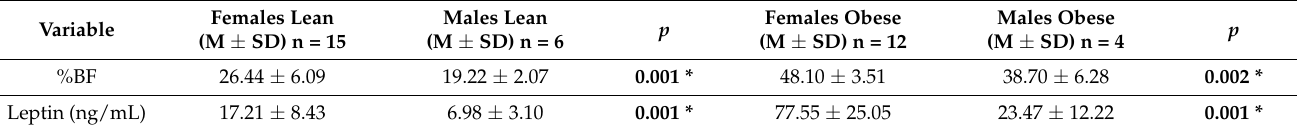
Table 3. Effect of Sex on Percent body fat and gut